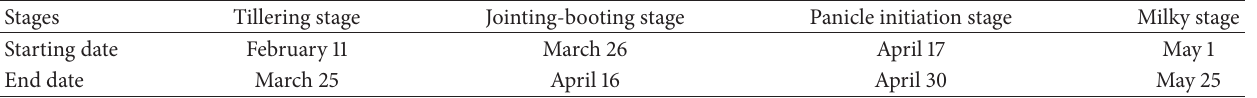
Table 2: Division of growth stages of winter wheat in